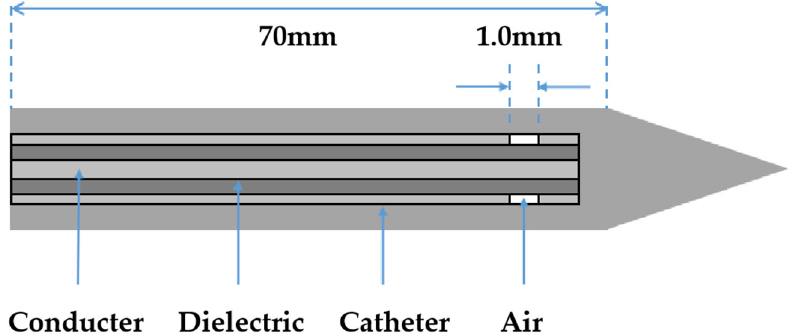
Figure 3. Microwave antenna model.